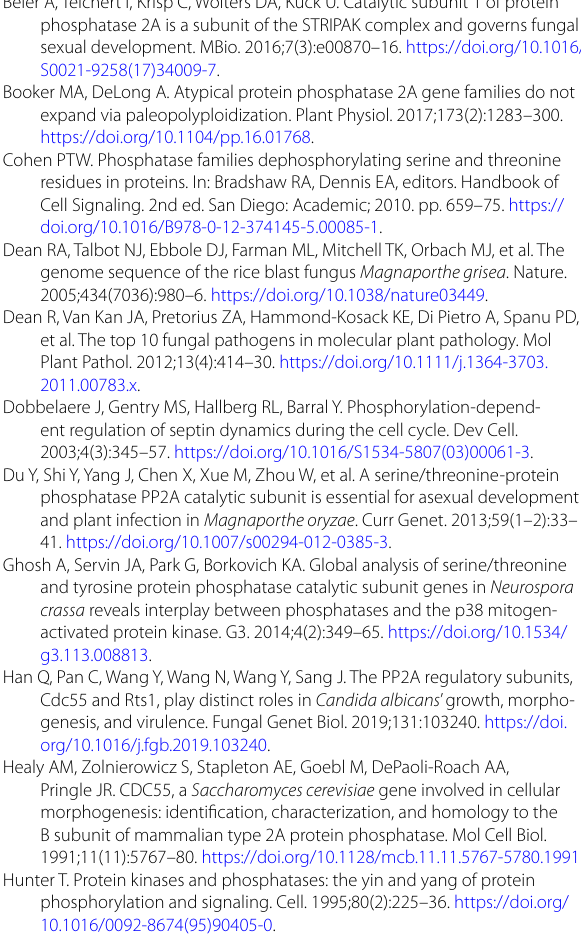
shift patterns of MoB56 with and without protein phosphatase treatment. Figure S3. Sequence alignment of the five MoB56 variants identified in